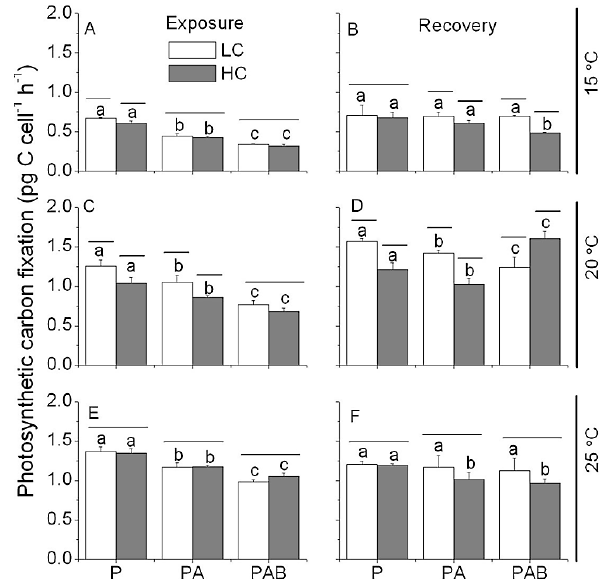
Fig. 6. Photosynthetic carbon fixation rates (in pgCcell − 1 h − 1 ) in the LC- (white bars) and HC- (black bars) grown cells of P. tri- cornutum exposed to three radiation treatments – PAB (irradiated above 295nm), PA (irradiances above 320nm) and P (irradiances above 395nm) – at 15, 20 and 25 ◦ C. (A) , (C) and (E) represent the carbon fixation rate during the 60min exposure, while (B) , (D) and (F) represent that during the 60min recovery period. The bars rep- resent the means ( n = 3) and the vertical lines on top are the stan- dard deviation. Lines above the histogram bars indicate significant differences between LC and HC, and different letters indicate sig- nificant differences among the radiation treatments within the HC- or LC-grown cells within each